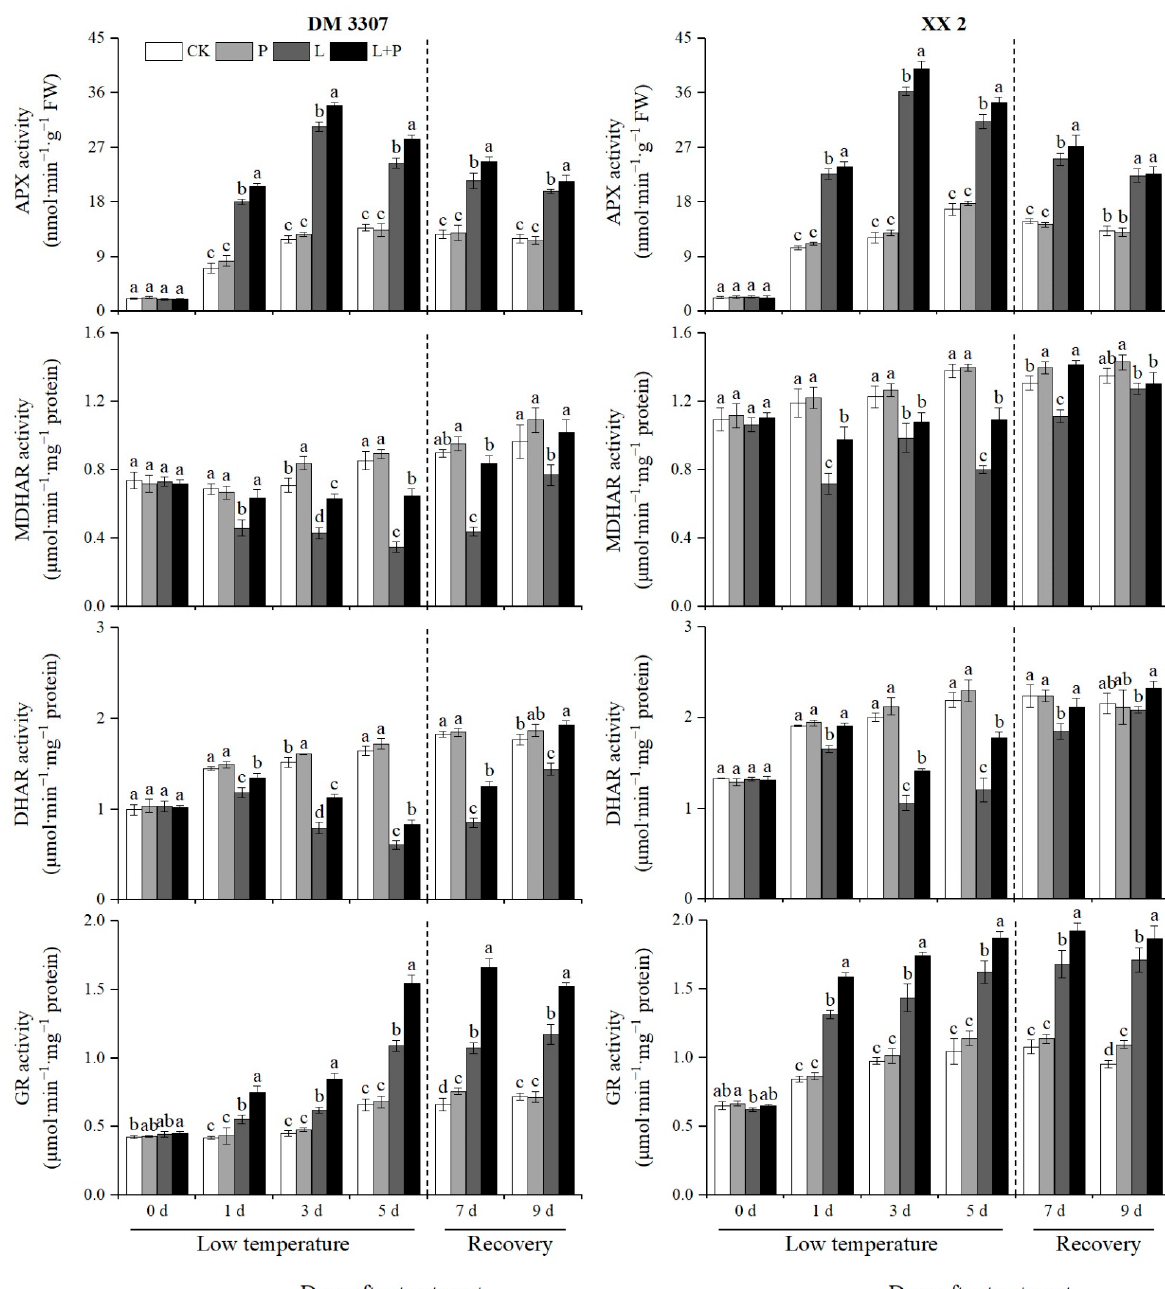
Figure 6. Effect of exogenous proline on the activity of APX, MDHAR, DHAR and GR in embryos of maize under the different treatment conditions. Notes: Data are expressed as mean ± standard deviation. Different letters within the same column indicate significant differences at the 5% level. CK: control group; P: proline treatment; L: low-temperature stress treatment; L + P: